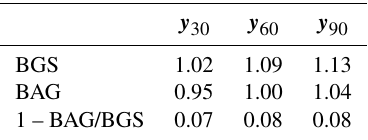
Table 2. E MSP of BGS and BAG from the outer cross-validation, averaged over all catchments; E MSP is based on centred and stan- dardised y i,j . The last row indicates the reduction in E MSP when BAG is used instead of BGS.